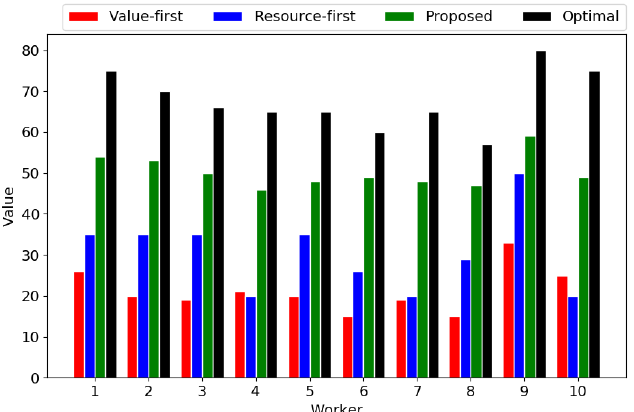
Figure 5. Values of the planned